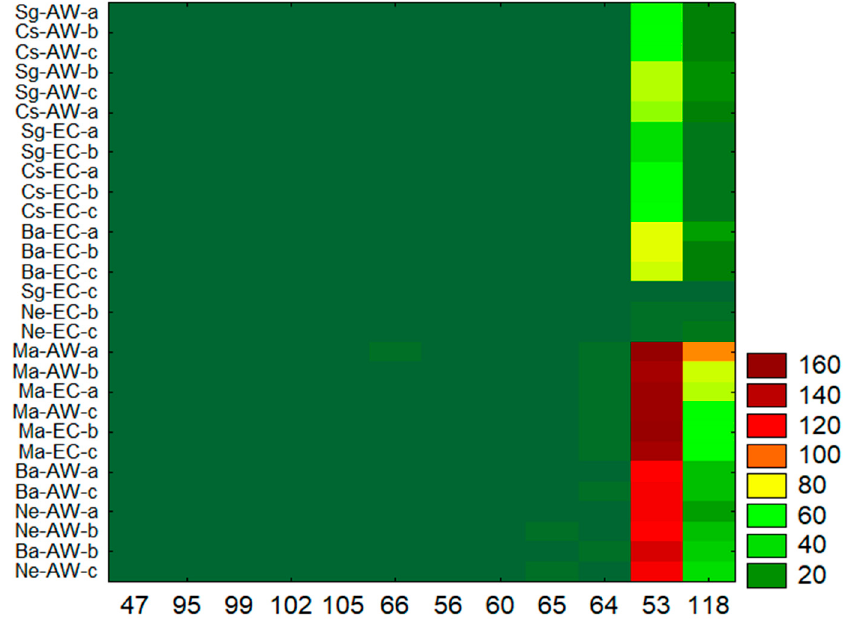
Figure 6. Two way-joining run on some selected alcohols (ppm). Sg, Sangiovese; Ma, Magliocco; Ba, Barbera; Cs, Cabernet-Sauvignon; Ne, Negroamaro. EC, strain EC1118; AW, strain AWRI796. 47: 2-methylbutane-1,3-diol; 53: 3-methylbutan-1-ol; 56: hexan-1-ol; 60: propan-1-ol; 64: 2-methylpropan- 1-ol; 65: 2-methyl-2-nitropropan-1-ol; 66: 3-methylsulfanylpropan-1-ol; 95: 3-methylhexan-3-ol; 99: